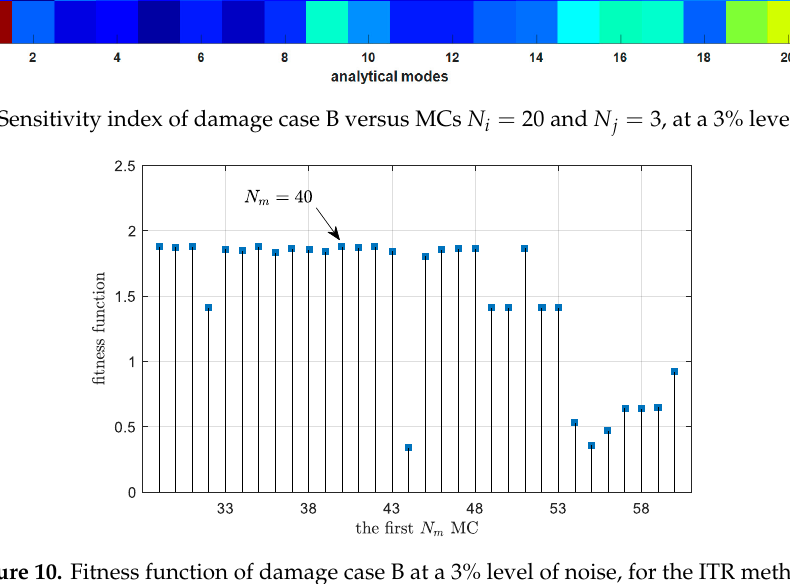
Figure 12. Fitness function of damage case C at a 3% level of noise, for the ITR method. Following this, the CMSE method employing 60 equations and the RCMSE method employing 54 equations are used to identify the damage, respectively. Figure 13 shows that both methods can correctly locate the actual damage. However, two false-positive alarms of damage to elements Nos. 5 and 17 are produced when using the CMSE method. At the same time, both methods overestimate the preset extent of the damage. This reveals that the robustness of the CMSE method against noise is slightly improved by eliminating six redundant equations.